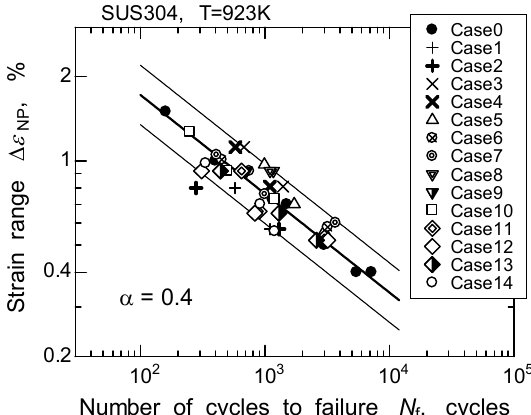
Figure 10: Correlation of non-proportional LCF lives with  NP